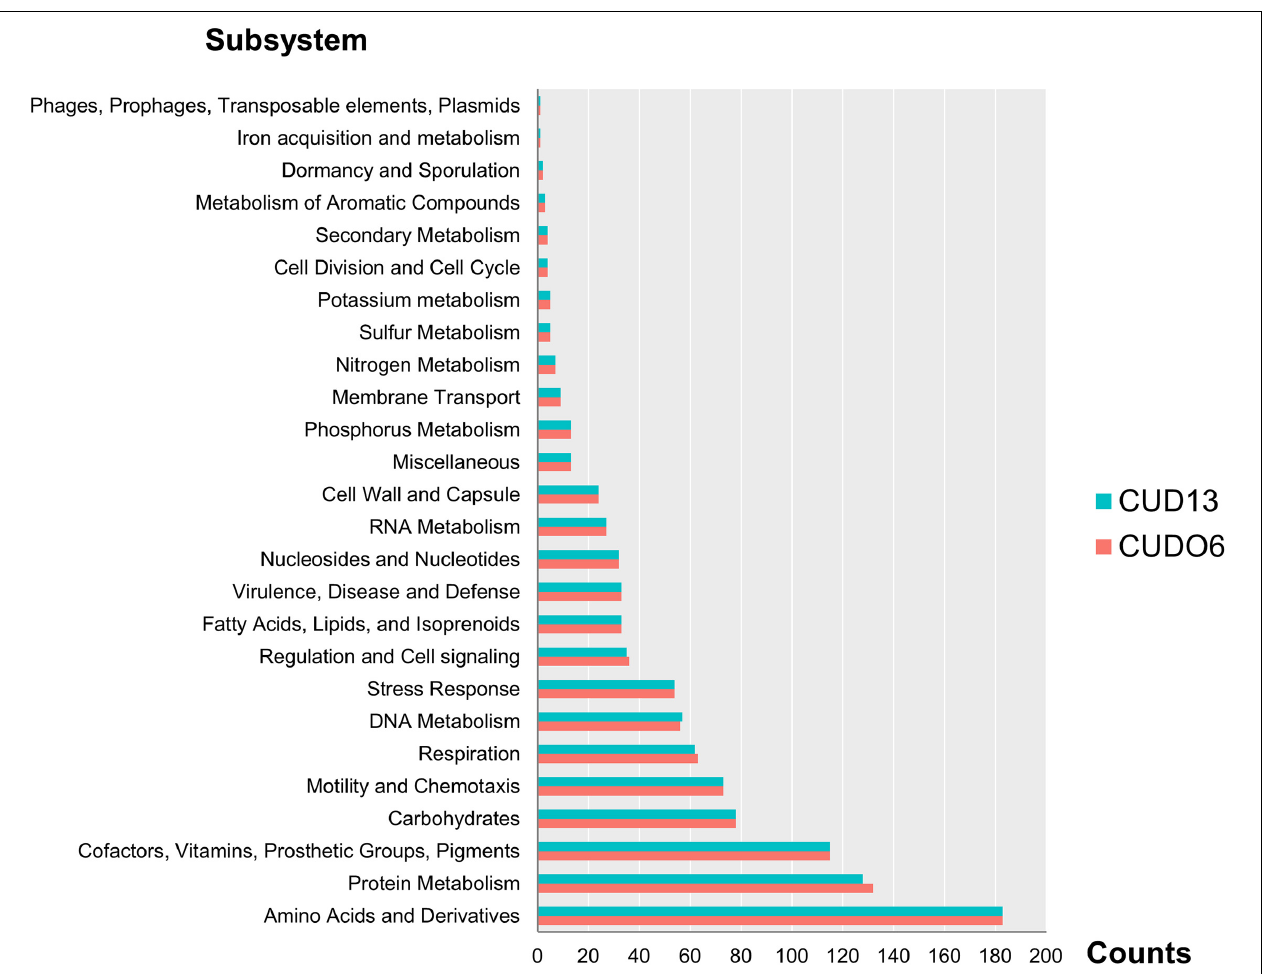
FIGURE 1 | Number of RAST subsystems annotated in the L. weilii serogroup Mini strains CUDO6 (pink bar) and CUD13 (blue bar). The CDS of strains CUDO6 and CUD13 were classified into 26 functional subsystems, and arranged according to the number of CDS in each category. Of these, amino acid and derivatives, protein metabolism, and cofactor had the largest number of identified CDS in both L. weilii